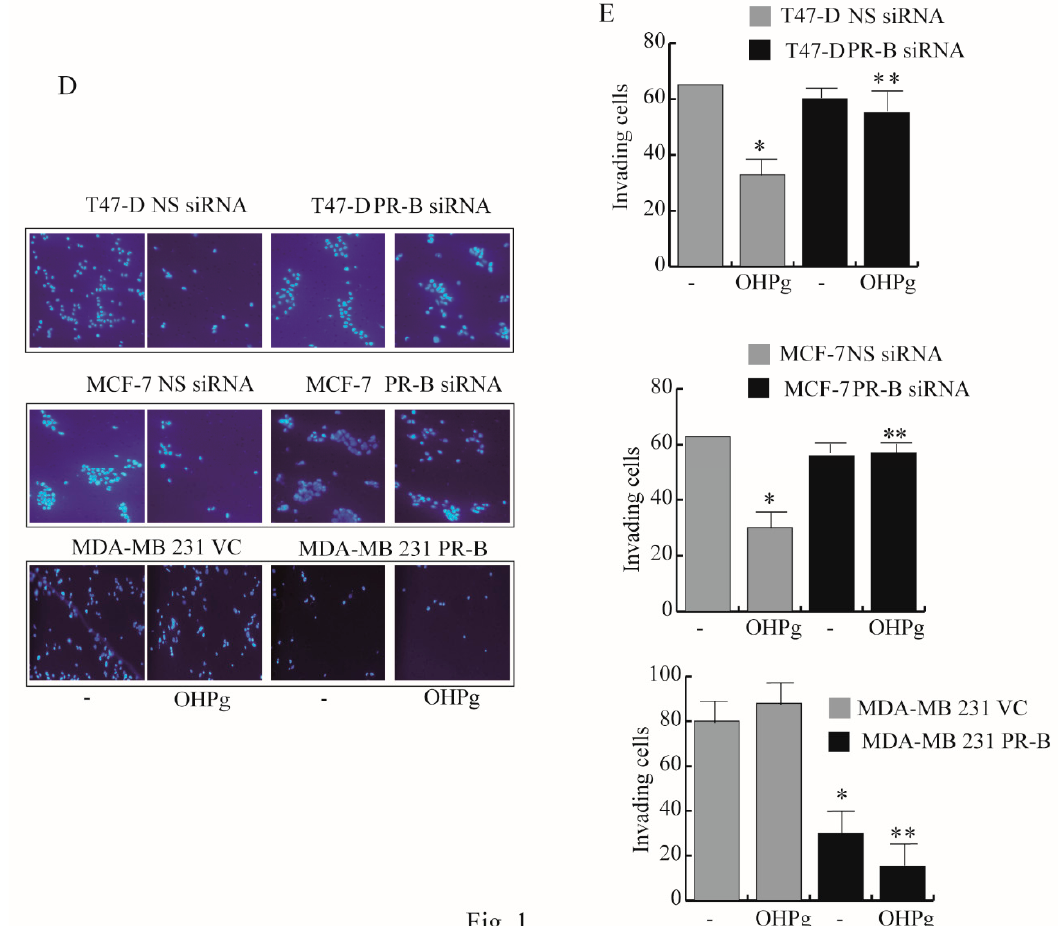
Figure 1. Hydroxyprogesterone (OHPg)-treated breast cancer cells show low motility, migration and invasion. ( A ) T47-D phalloidin staining of F-actin (stress fibers, red). 4 ′ ,6-diamidino-2-phenylindole (DAPI), nuclear staining. ( B,C ) Wound-healing assay (insets: time 0). T47-D and MCF-7 cells were transfected with non specific (NS) or targeted against Progesterone-Receptor (PR)-B siRNA. MDA-MB-231 were transfected with vector control (VC) or progesterone receptor B (PR-B) expression vector. ( D ) Transmigration assay, ( E ) Invasion assay. Columns are the mean of three independent experiments each in triplicate; bars, SD; * p ≤ 0.05 vs. vehicle treated cells. ** p ≤ 0.05 vs. OHPg-treated cells.